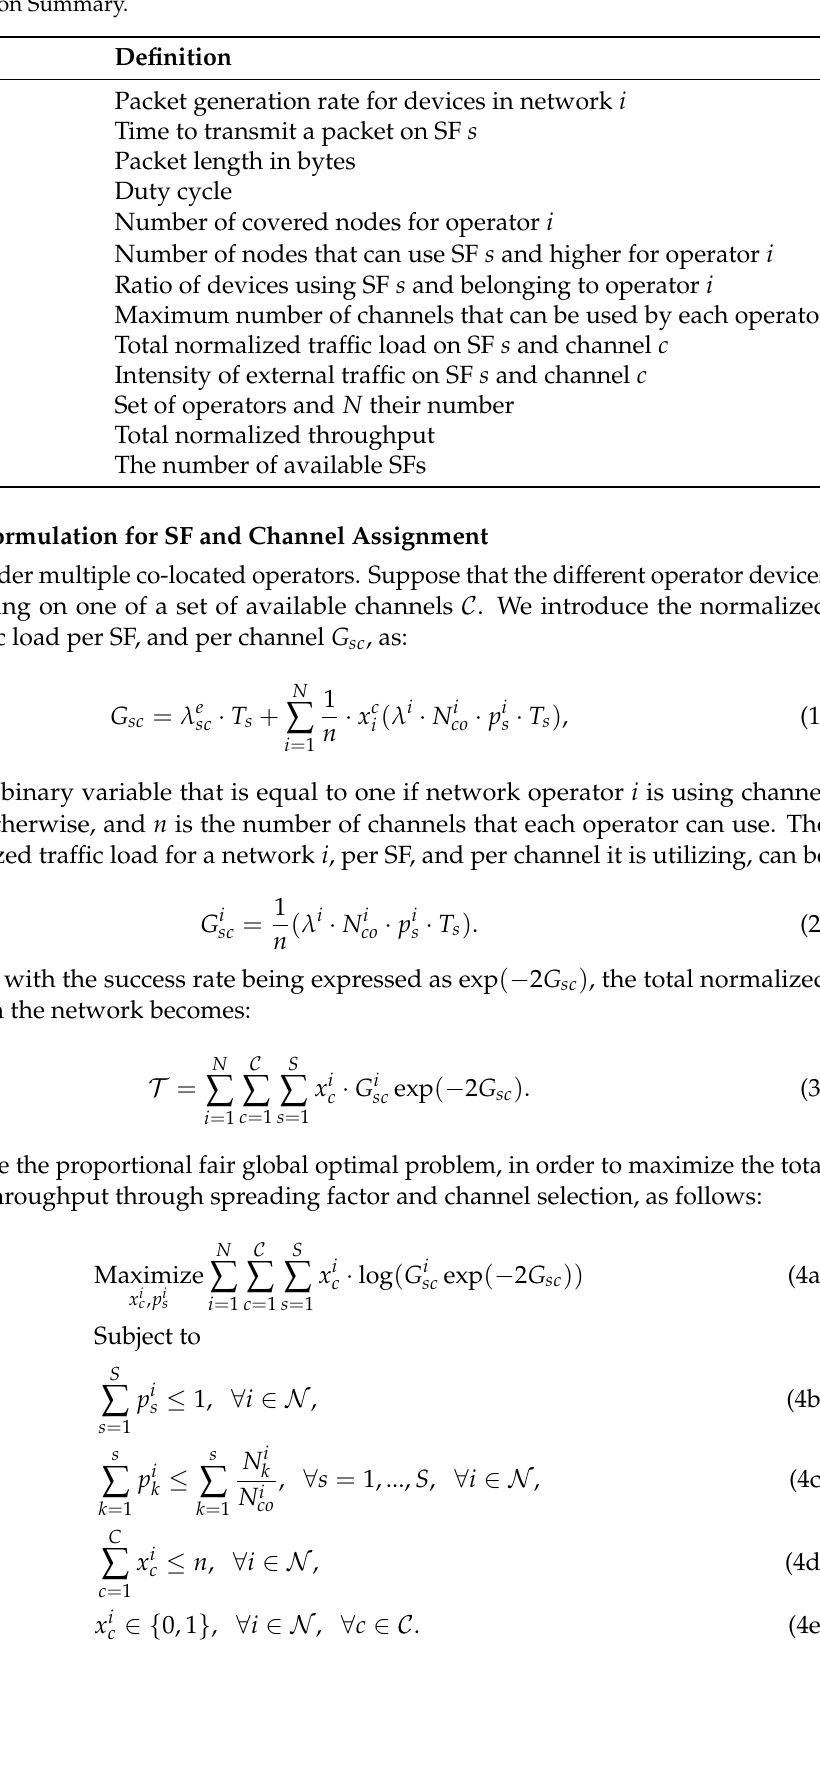
Table 2. Notation